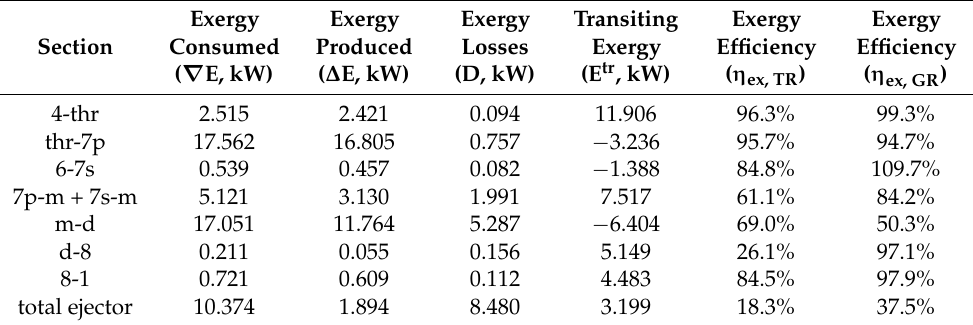
Table 2. Exergy metrics in different ejector